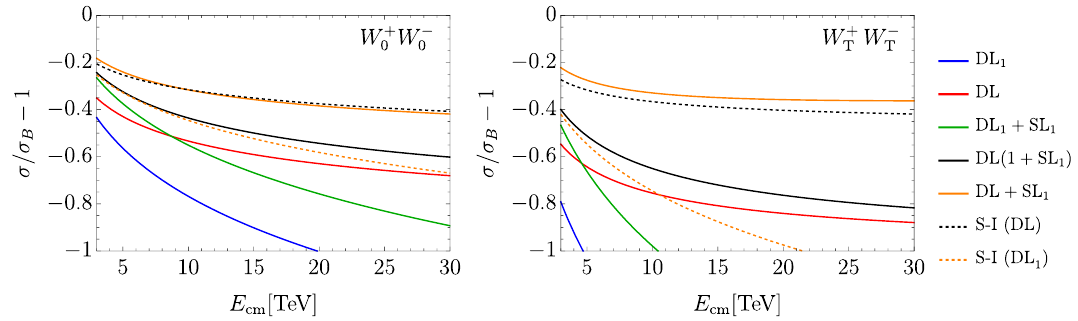
Figure 4. Same as figure 3, but for di-boson production. As explained in section 3.2, the cross- sections for W + W − production are integrated in the angular region θ